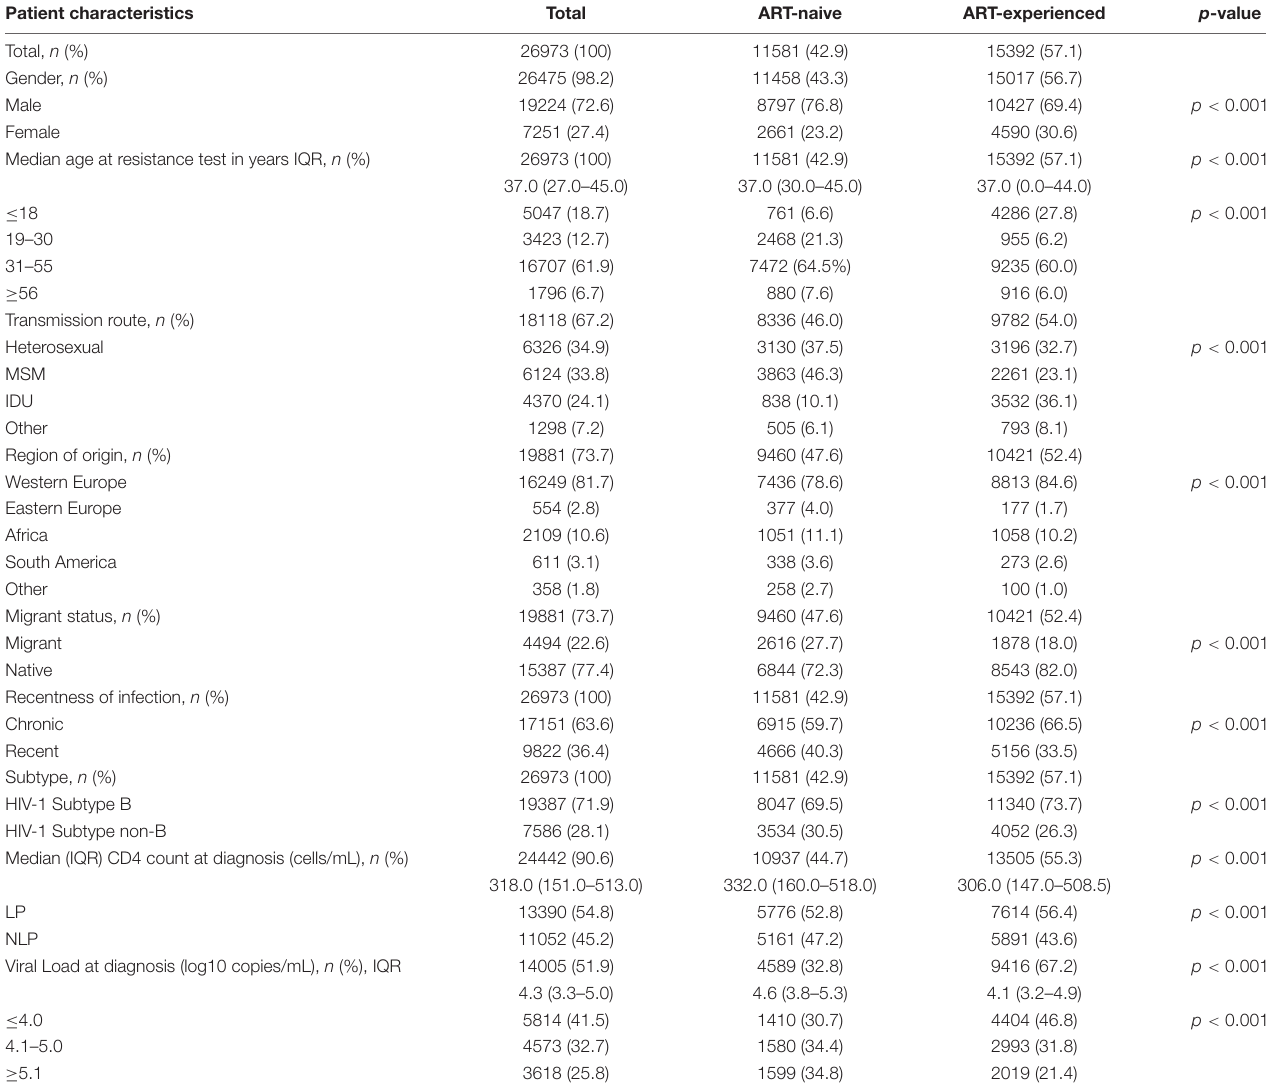
TABLE 1 | Sociodemographic and clinical patient characteristics.